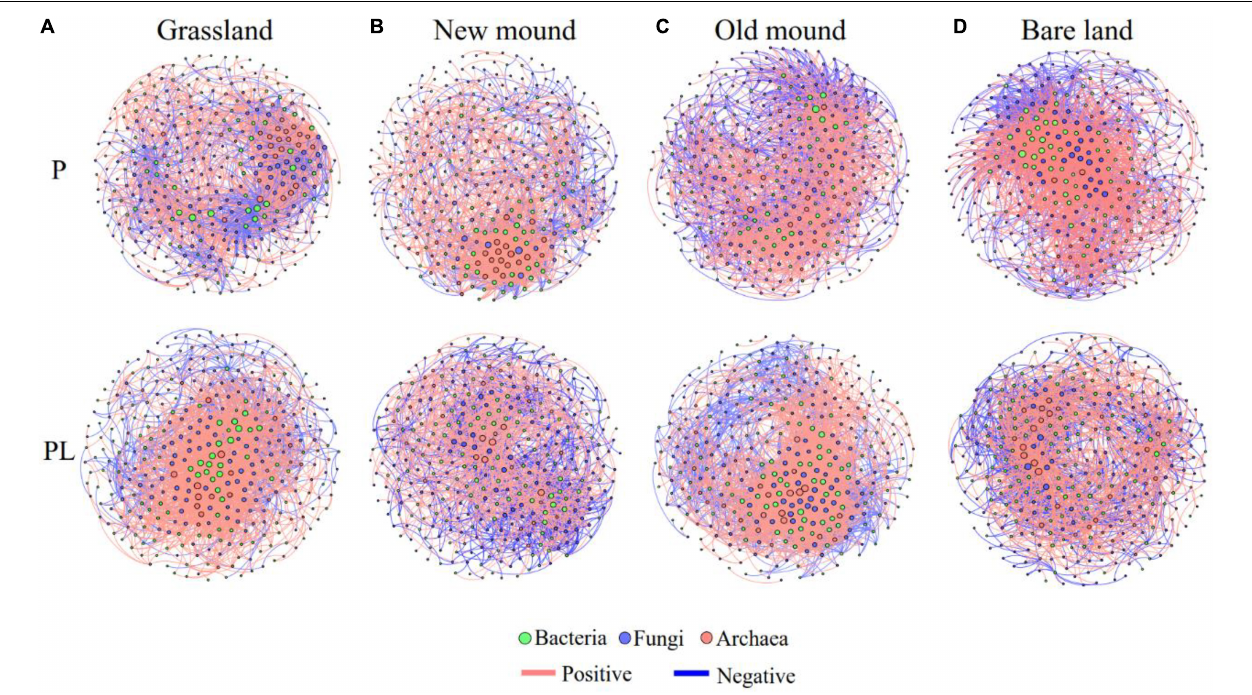
FIGURE 7 | The microbial networks in the grassland (A) , new mound (B) , old mound (C) , and bare land (D) . Nodes represent main OTUs (relative abundance > 0.01%) of bacterial (green), fungal (blue), and archaeal (pink) communities; edges represent significant Spearman correlations (| r | > 0.7, P < 0.05). Pink and dark blue edges indicate positive and negative correlations, respectively. P, pika disturbance; PL, grazing and pika disturbance. (For detailed network properties, see Supplementary Tables 9,10 ).